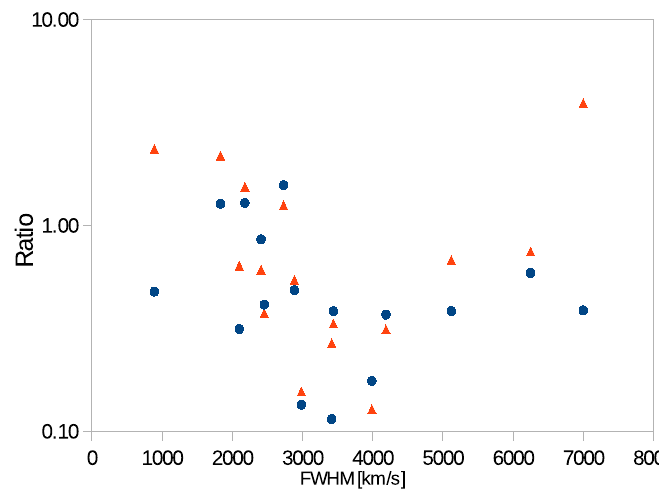
Figure 5. The comparison of SMBH masses obtained in this paper with previous reverberation mapping results from Kaspi et al. [62]. Blue full circles represent the ratio of masses from this work and the masses from the reverberation results obtained using FWHM of averaged line profiles, while the orange triangles correspond to ratio with reverberation masses from the RMS